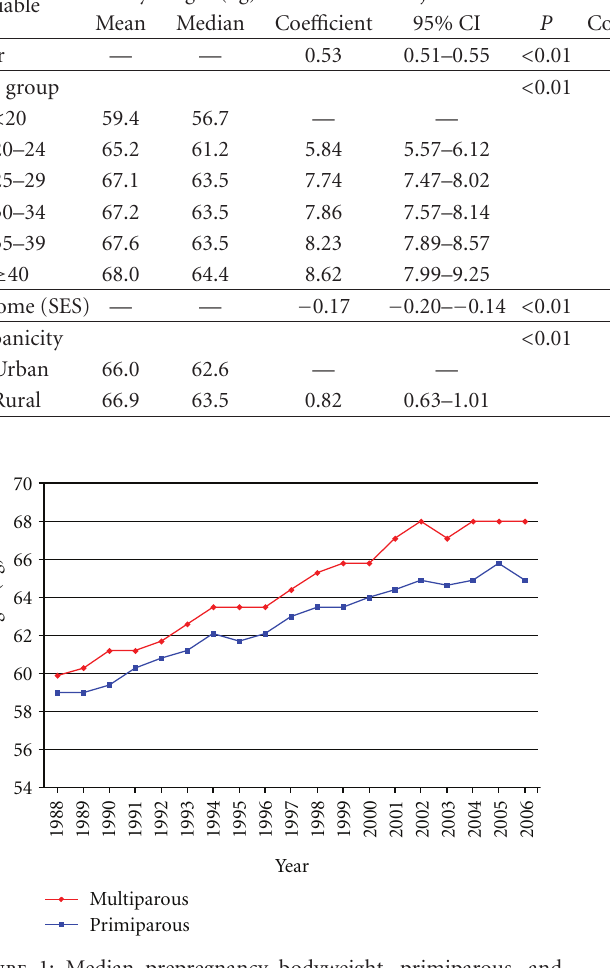
(year and income deciles), the coe ffi cient represents the weight change (in kg) for every unit change in either year or income decile. For categorical variables the coe ffi cient represents the weight change in kg for each category, com- pared to the mean weight in the baseline category (i.e., the coe ffi cient for the constant). Body weight increased by 0.5 kg each year on average across the duration of the study